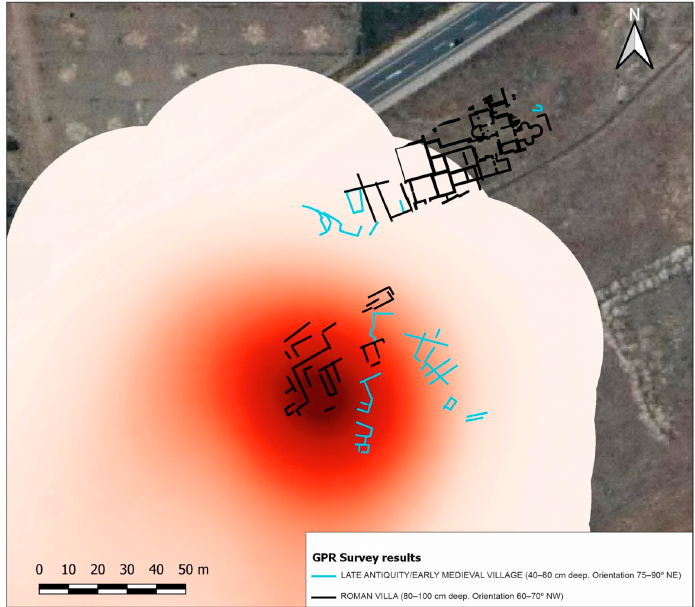
Figure 10. An image of the structural anomalies obtained by geophysical prospecting using GPR overlaid on the kernel density map interpolated from the concentrations of surface materials. On the basis of the depth and orientation of the anomalies, we differentiated remains from the Roman villa (black) and those from a possible Late Antiquity–Early Middle Ages village (blue).